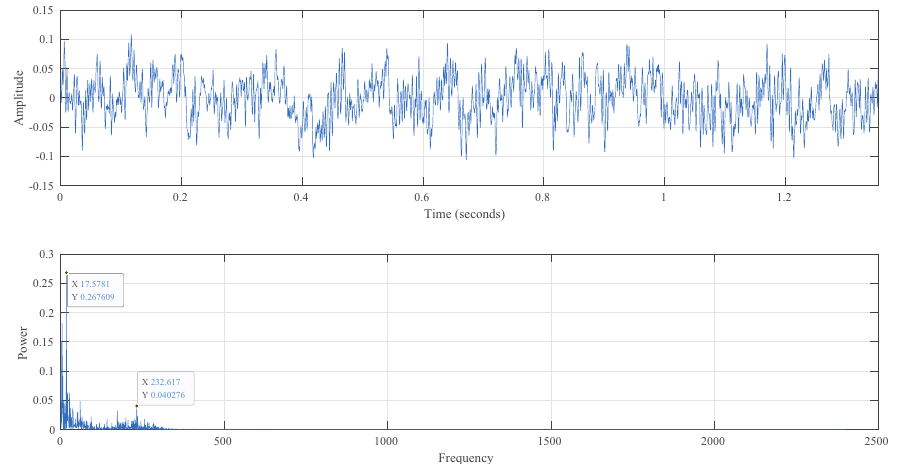
Figure 5. Time- and frequency-domain diagrams of environmental noise.